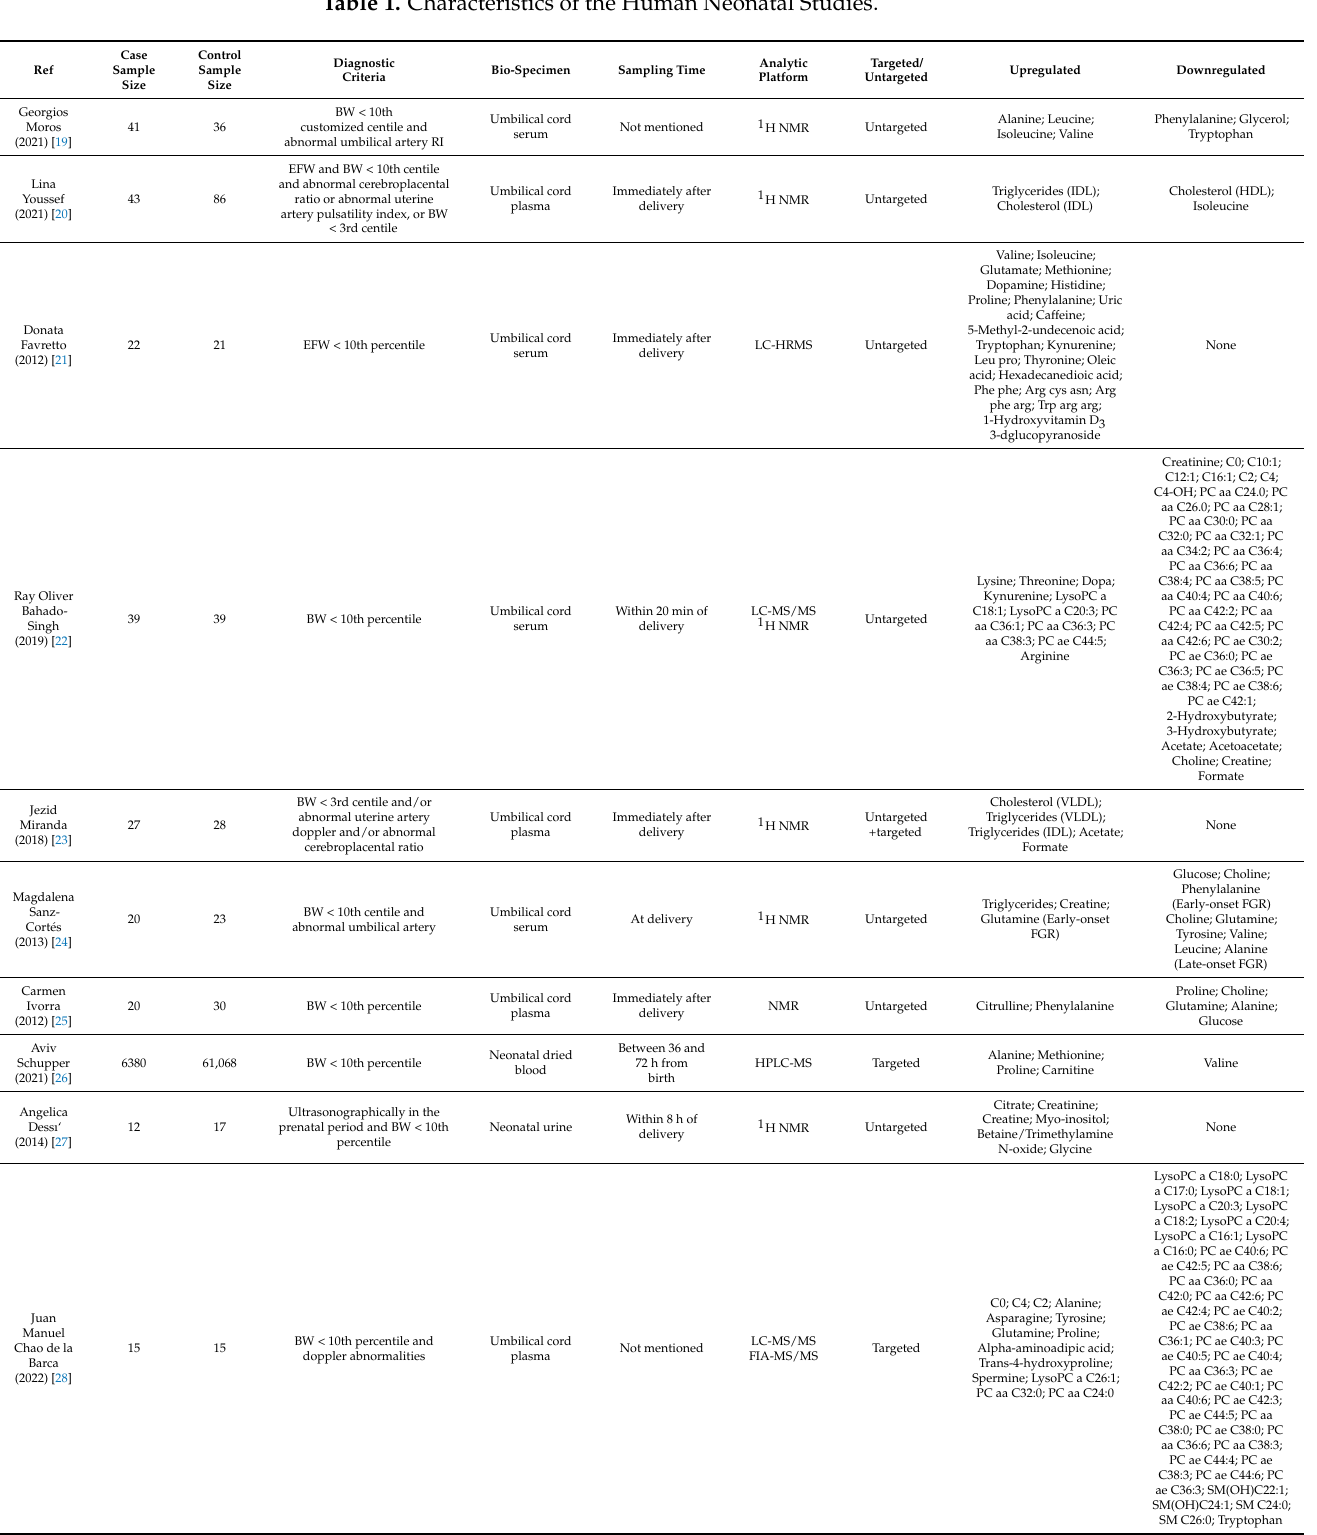
Table 1. Characteristics of the Human Neonatal